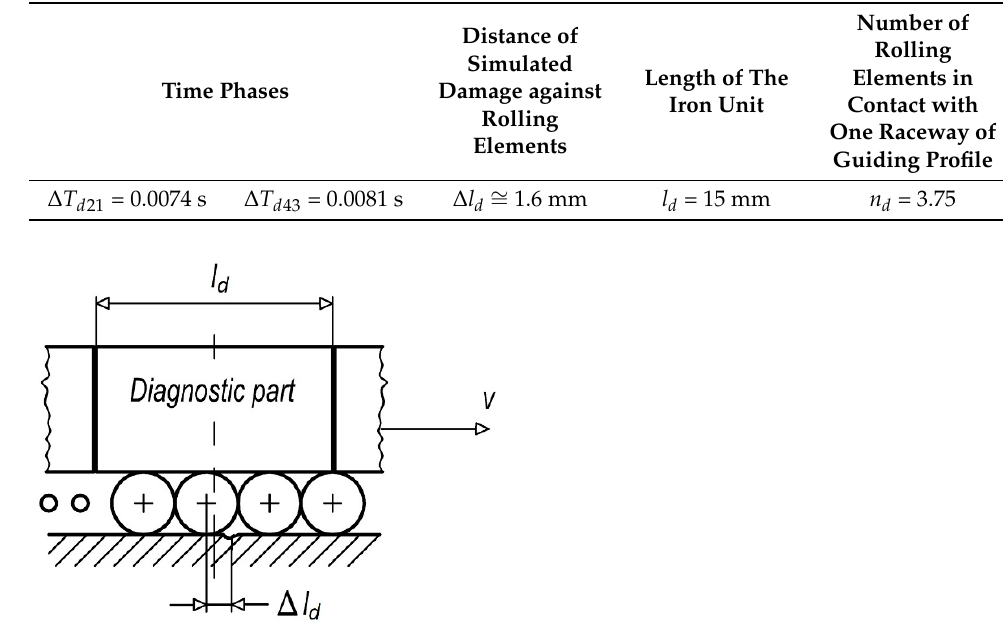
Figure 25. The position of the simulated damage against rolling elements. Table 10. Results of Equations (24)–(27).